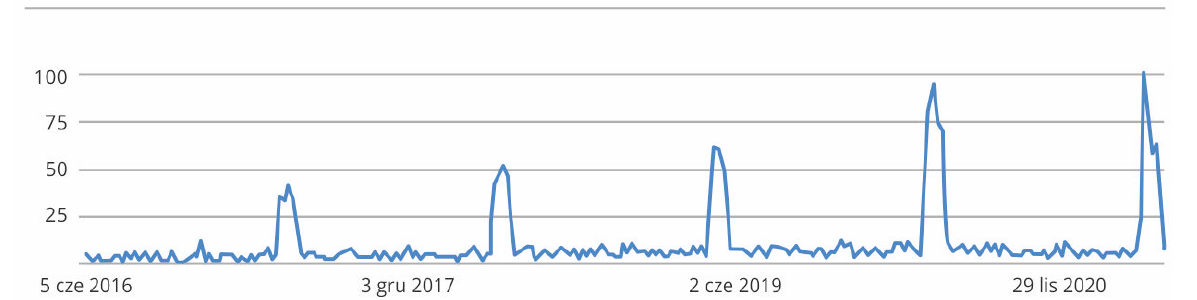
Figure 6. Frequency of searches for the keyword “Litany of Loreto” over the last five years; source: Google Trends, https://www.google.com/trends (accessed on 10 July 2021).